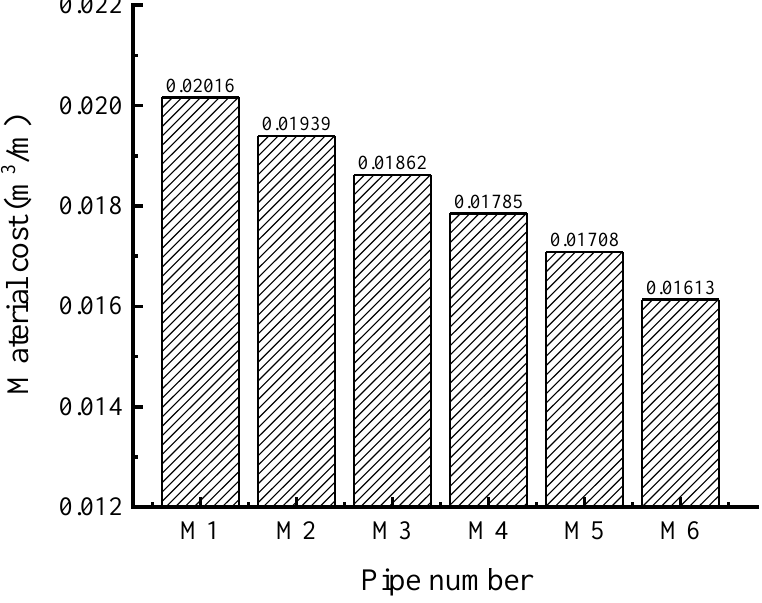
Figure 21. Material cost per unit length of pipe.